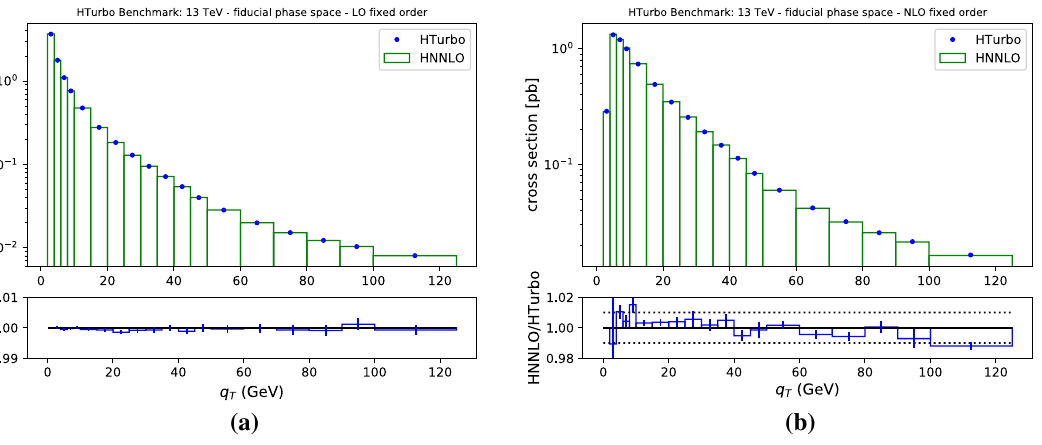
Fig. 6 Comparison of fiducial differential cross sections computed tum distribution at LO ( a ) and NLO ( b ) accuracy. The top panels show √ s = 13 TeV. The fiducial phase space with HRes and HTurbo at absolute cross sections, and the bottom panels show ratios of HTurbo to HRes is defined in the text. Fixed-order component of the transverse momen-